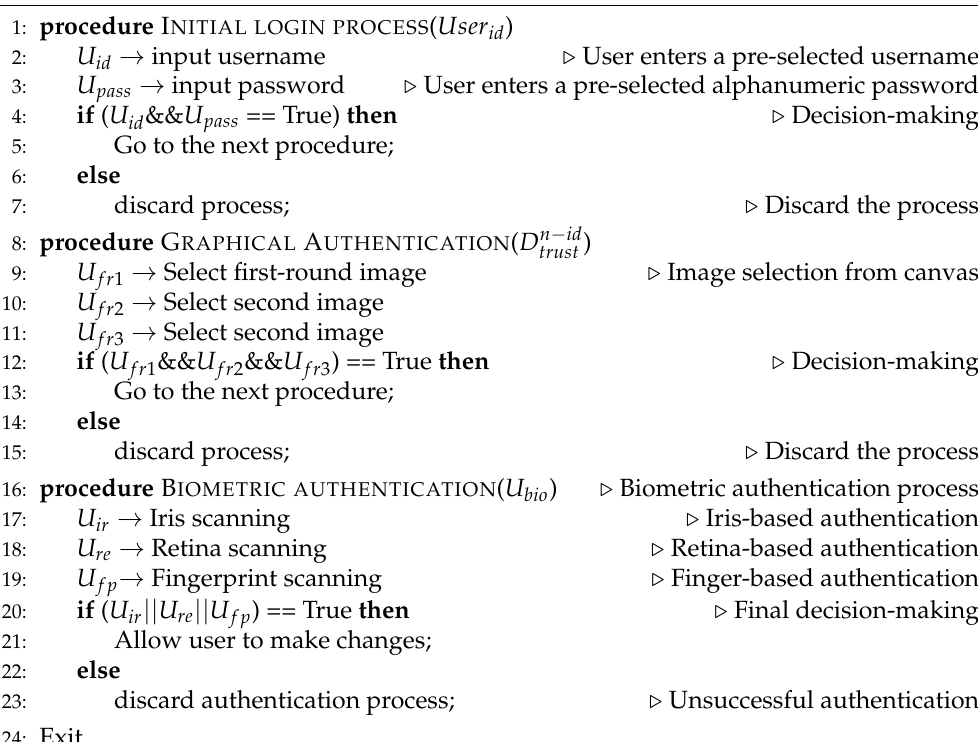
Algorithm 1 Hybrid user authentication